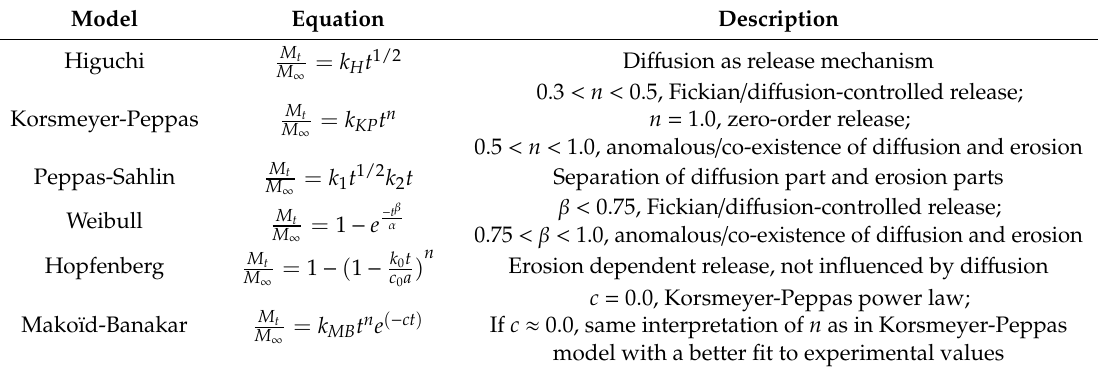
Table 2. Applied mathematical models and their descriptions